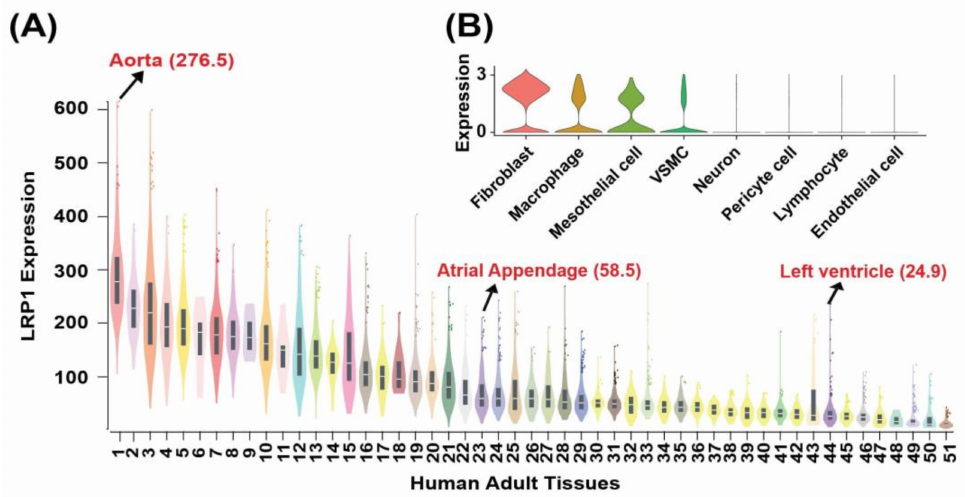
Figure 3. The expression of LRP1 in adult human tissues. ( A ) Transcriptional expression of LRP1 in the adult human tissues. The highest transcriptional expression of LRP1 in the aorta among 54 adult human tissues from the GTEx database. ( B ) Analysis of scRNA-seq data of human adult aorta demonstrated that LRP1 is highly expressed in fibroblasts, mesothelial, and vascular smooth muscle cells (VSMCs) in the human adult aorta (from Pirruccello et al., 2022; a total of 54,092 cells [25]). ( A ) 1. Aorta, 2. Ovary, 3. Adipose-Subcutaneous, 4. Coronary Artery, 5. Tibial Nerve, 6. Ectocervix, 7. Tibial Artery, 8. Uterus, 9. Endocervix, 10. Omentum (adipose-Visceral), 11. Fallopian Tube,